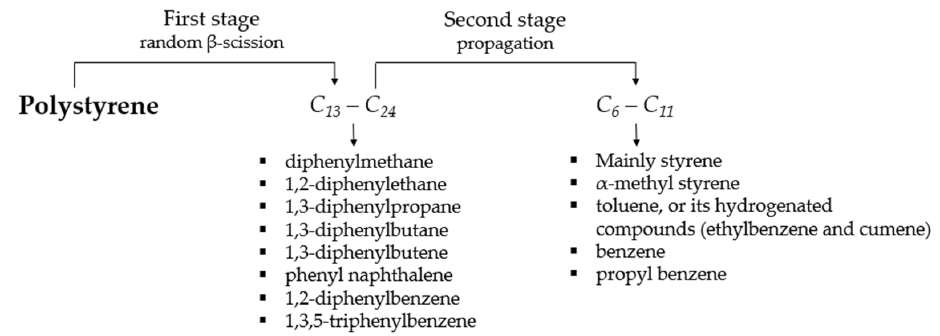
Figure 5. Reaction mechanism for the degradation of polystyrene.